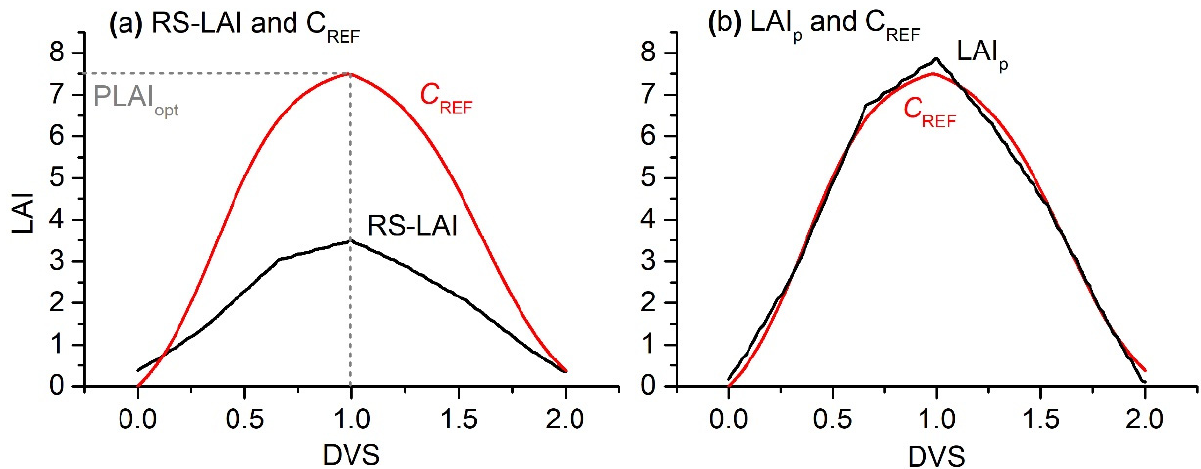
Figure 3. An example of deriving LAI p from RS-LAI and C REF . LAI p on the right panel ( b ) was derived by fitting the RS-LAI on the left panel ( a ) to C REF using the least-square method.